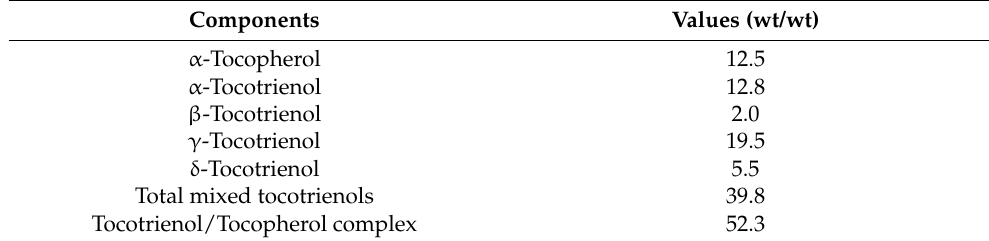
Table 2. Composition of tocotrienol-rich fractions